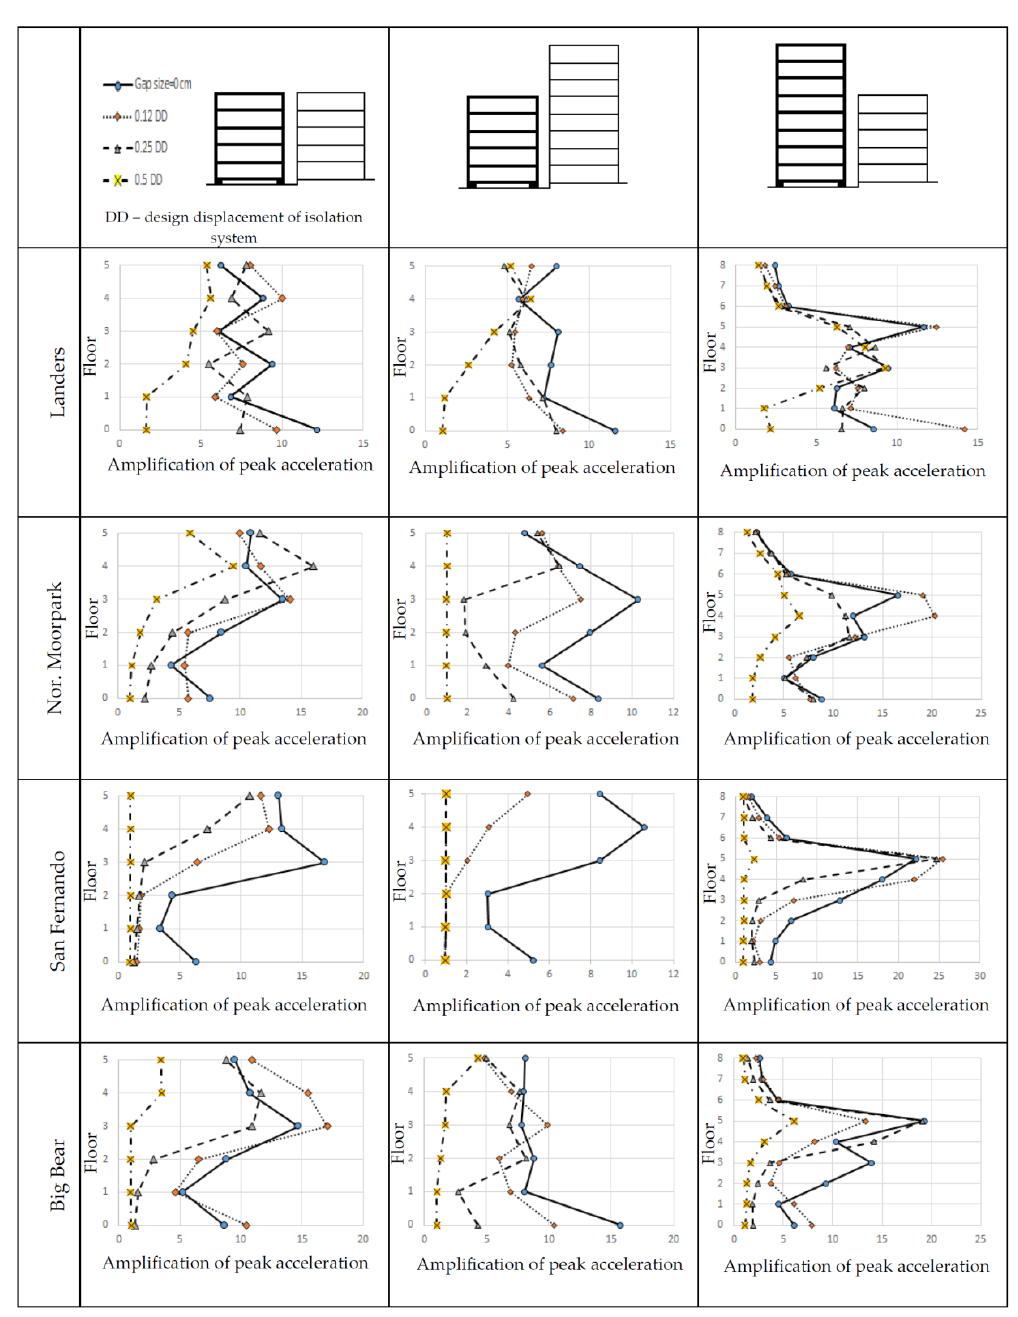
Figure 6. Acceleration amplification factors due to pounding for different gap sizes and various stories of the base-isolated building during the Landers, Northridge (station: Moorpark), San Fernando, and Big Bear earthquakes.